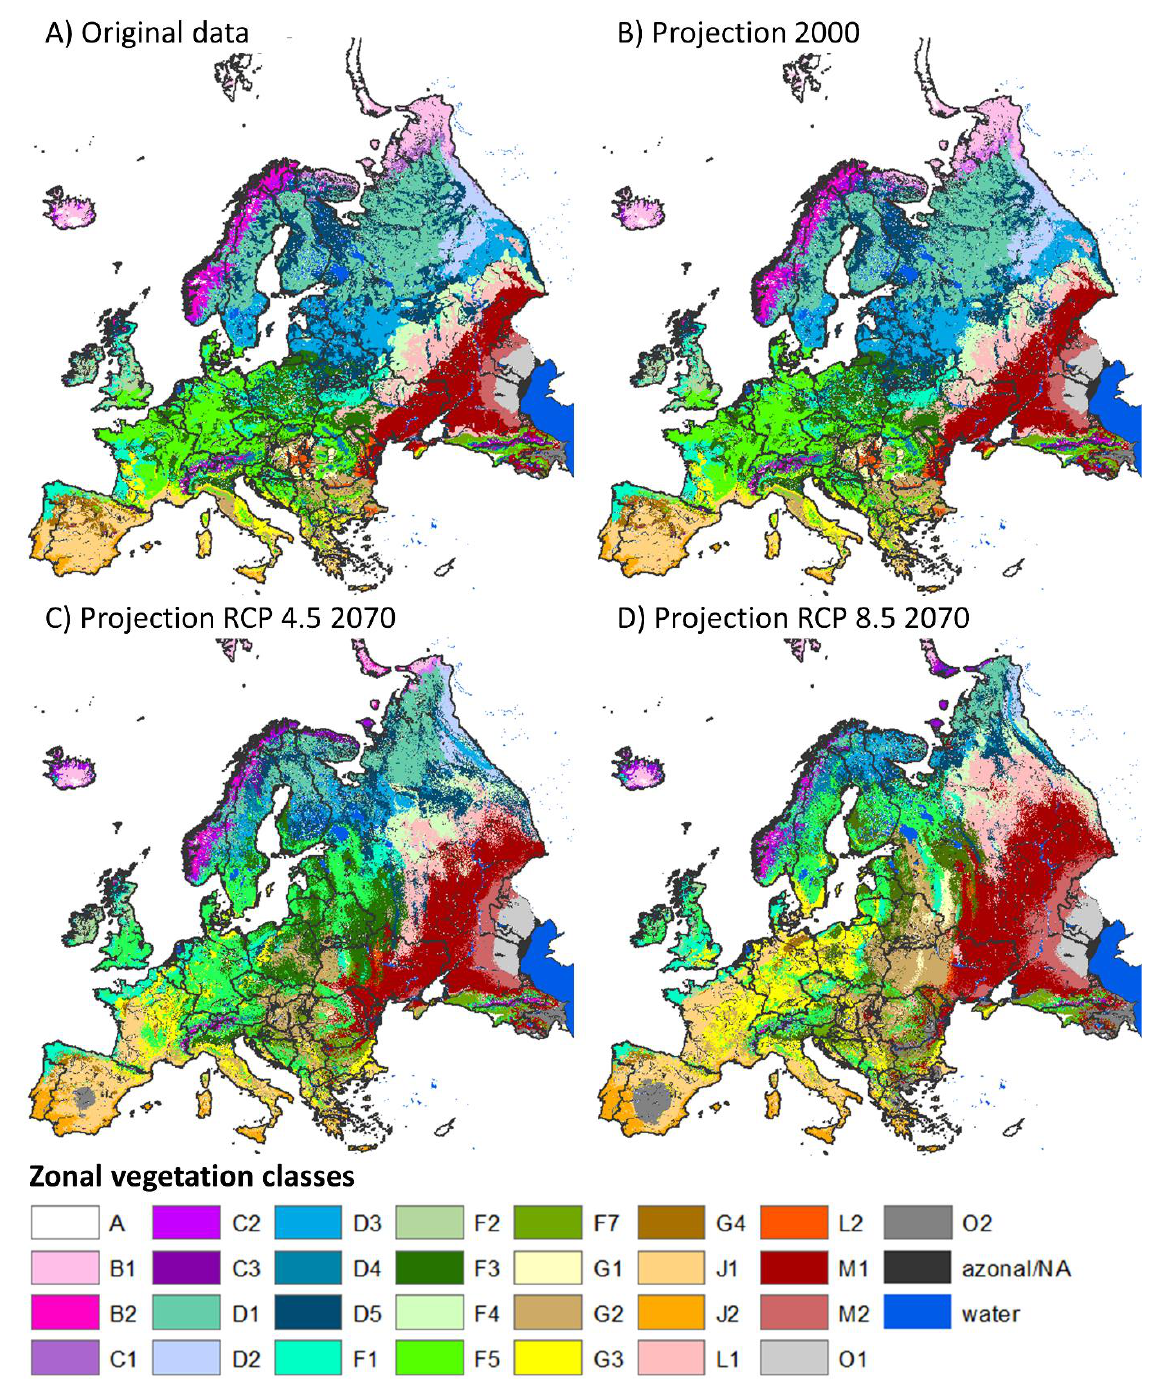
Figure 2. Vegetation potentials of Europe: ( A ) Original data (zonal vegetation of map of Europe (Bohn et al. 2000)), ( B ) corresponding model-based representation of this map for current climate data (averaged for 1979 – 2013), ( C ) projection for RCP 4.5 and ( D ) projection for RCP 8.5 for time slice 2061 – 2080 (2070). Class abbreviations are given in Table 1.